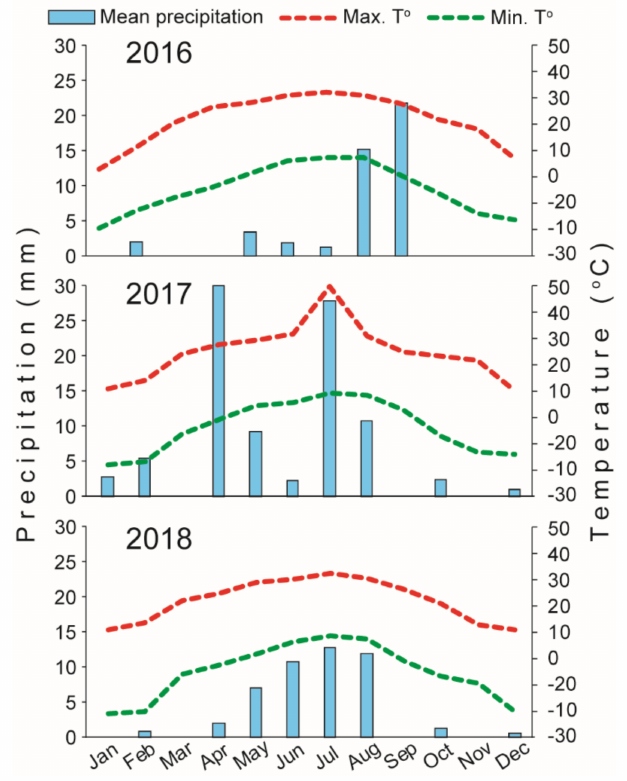
Figure 2. Monthly maximum and minimum temperatures, and precipitation for 2016, 2017, and 2018 at Cele Oasis of Tarim Basin of the Taklamakan Desert, Xinjian, China. Source: Centre for Hydrometeorological station at